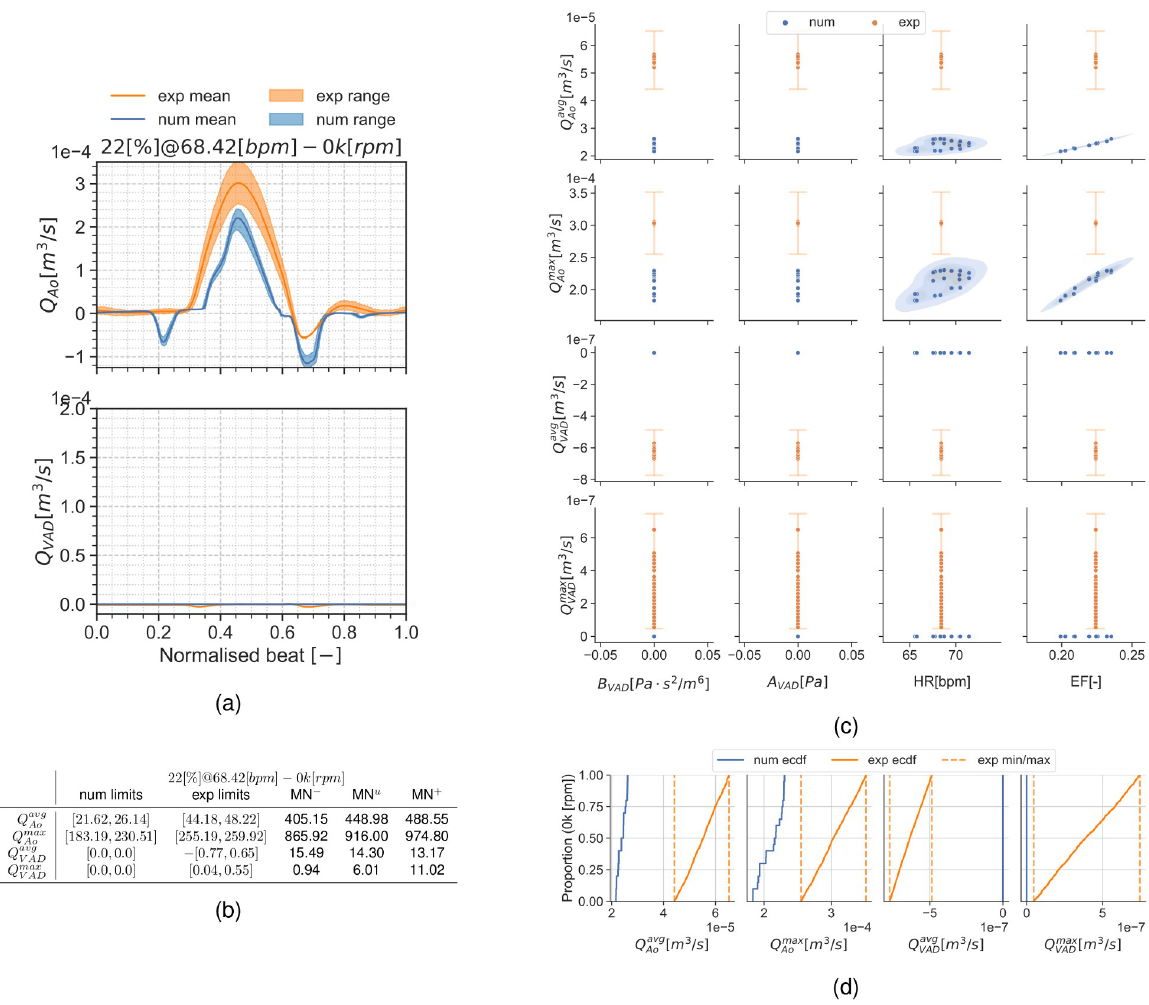
Fig 5. Summary for the condition 22[%]@68.42[ bpm ] and 0 k [ rpm ]. (a): aortic valve and LVAD flows. (b): validation metrics. (c): scatter plot showing the experimental and simulation data. (d): ECDF for the simulation, experimental data limits and the constructed uniform distribution.